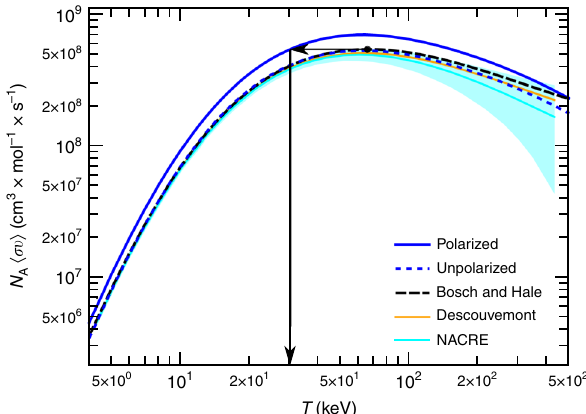
Fig. 5 DT reaction rate with and without polarization. Comparison between σ ν h i , with N the computed DT reaction rate ( N A the Avogadro number) for A unpolarized and polarized fuel with aligned spins as a function of the temperature, T . The “ Polarized ” and “ Unpolarized ” labels stand for the present results obtained with the phenomenological correction of − 5 keV to the position of the 3/2 + resonance (dubbed NCSMC-pheno). We use reactants ’ polarization parameters achievable in the laboratory, that is p ; p 0 : 8 and q 0 : 8. Also shown for comparison are the unpolarized z zz ¼ z ¼ reaction rates obtained from the widely adopted parametrization of the DT fusion cross section of Bosch and Hale 34 (labeled as “ Bosh and Hale ” ), from the R -matrix fi t of Descouvemont 35 (labeled as “ Descouvemont ” ) and from the NACRE compilation 36 (labeled as “ NACRE ” ). The arrows in the fi gure show that, with polarization, a reaction rate of equivalent magnitude as the apex of the unpolarized reaction rate is reached at lower